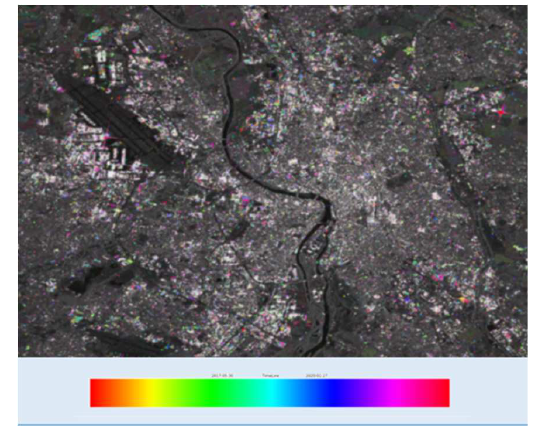
Fig. 12. Change detection on Toulouse